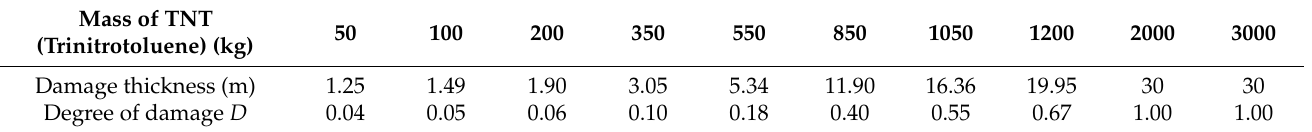
Table 1. Degree of damage to the arch dam when the middle part of the dam was subjected to underwater contact explosion. Mass of TNT 50 (Trinitrotoluene) (kg) Damage thickness